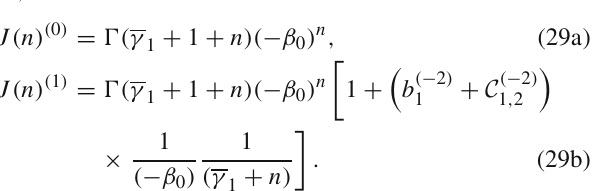
/ (cid:8) d X and the residue ratios d X in the MS scheme ( ¯ c j = 0 for j ≥ 5), with N f = 3. Note that D = 2 p for IR j , k p , k p , k